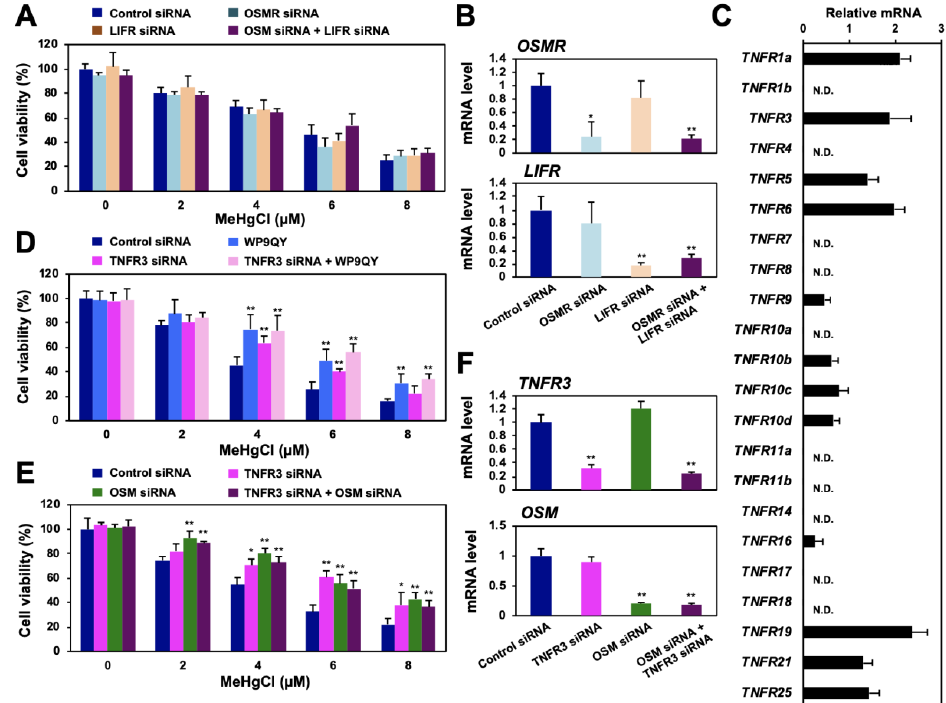
Figure 5. Identification of the TNF receptor associated with methylmercury toxicity via HOXB13 and OSM. ( A ) HEK293 cells were transfected with control siRNA, OSMR siRNA, and/or LIF receptor (LIFR) siRNA for 48 h and exposed to the indicated concentrations of methylmercuric chloride (MeHgCl) for 24 h. Cell viability was measured by alamarBlue assay. ( B ) Quantitative PCR for OSMR mRNA (upper panel) or LIFR mRNA (lower panel) was performed. Represented data indicate relative values, with the control as 1, normalized to each GAPDH mRNA level. ( C ) mRNA levels of TNF receptors in HEK293 cells were determined by qPCR. ( D ) Cells were transfected with TNFR3 siRNA (#2) for 48 h. WP9QY (10 µM) was added to the medium 90 min before exposure to methylmercuric chloride (MeHgCl) for 24 h. No significant difference was found between WP9QY and TNFR3 siRNA + WP9QY. ( E ) Cells were transfected with TNFR3 siRNA (#2) and/or OSM siRNA (#2) for 48 h. Cells were exposed to MeHgCl for 24 h, and cell viability was measured by alamarBlue assay. No significant di ff erence was found between OSM siRNA and TNFR3 siRNA + OSM siRNA. ( F ) Control cells (without methylmercury exposure) were harvested, and qPCR for OSM (upper panel) or HOXB13 (lower panel) was performed. Representative data indicate the relative values, with control as 1, normalized to each GAPDH mRNA level. All values are presented as mean ± S.D. of three individual experiments. * p < 0.05 vs. control siRNA, ** p < 0.01 vs. control siRNA. N.D. indicates not